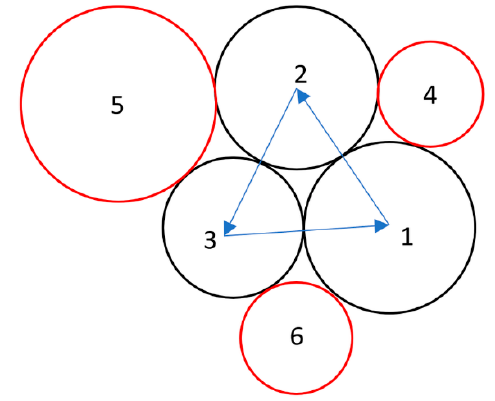
Figure 2. Powder bed packing with advancing front approach; 1–6 denote powders packed in sequence.